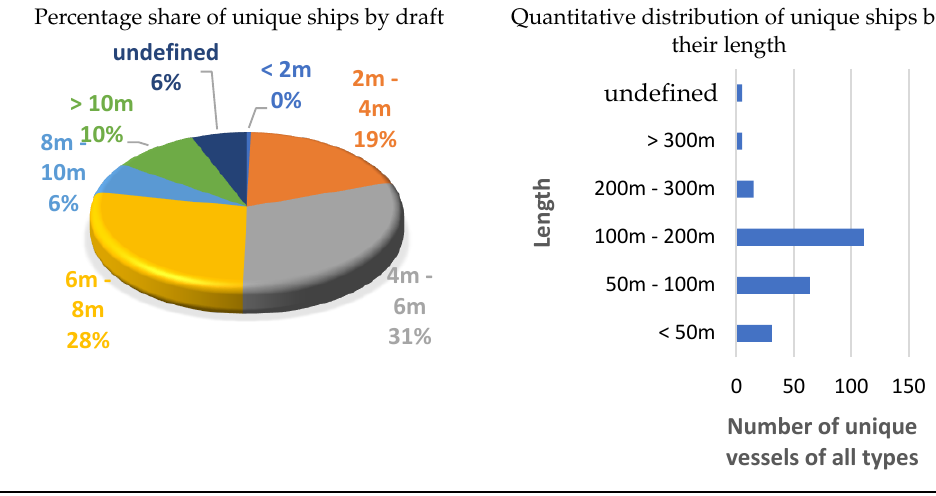
Table 13. List of vessels on the 3-3 measurement profile, broken down by type.